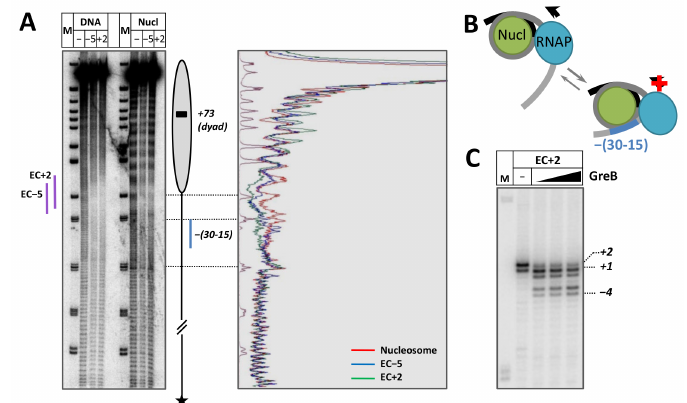
Figure 6. Formation of an i-loop containing backtracked RNAP at the position +1. ( A ) On the left: EC-5 and EC+2 were formed on the 603 DNA and nucleosomes and incubated in the presence of hydroxyl radicals. End-labeled DNA was analyzed by denaturing PAGE (on the left). M—pBR322 MspI digest. Nucleosome position is indicated by grey oval. On the right: Scans of the lanes with nucleosomes and nucleosomal ECs. Purple and blue lines indicate DNA regions protected from hydroxyl radicals by RNA polymerase and DNA region upstream the RNAP protected only in EC+2, respectively. ( B ) EC+2 contains an unstable i-loop. Direction of transcription and arrest of RNAP are indicated by black arrows and red cross, respectively. ( C ) Incubation of EC+2 in the presence of 10, 20 or 40 nM of GreB. Analysis of pulse-labeled RNA by denaturing PAGE. M—pBR322 MspI digest. Positions of active center of RNAP are indicated on the